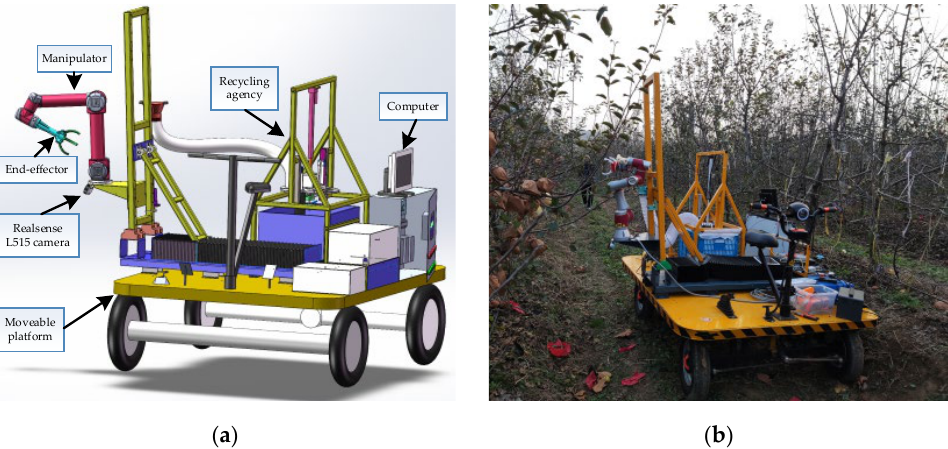
Figure 1. Pictures of apple-picking robots: ( a ) system architecture of the apple-picking robot; ( b ) apple-picking robot picking in an orchard.